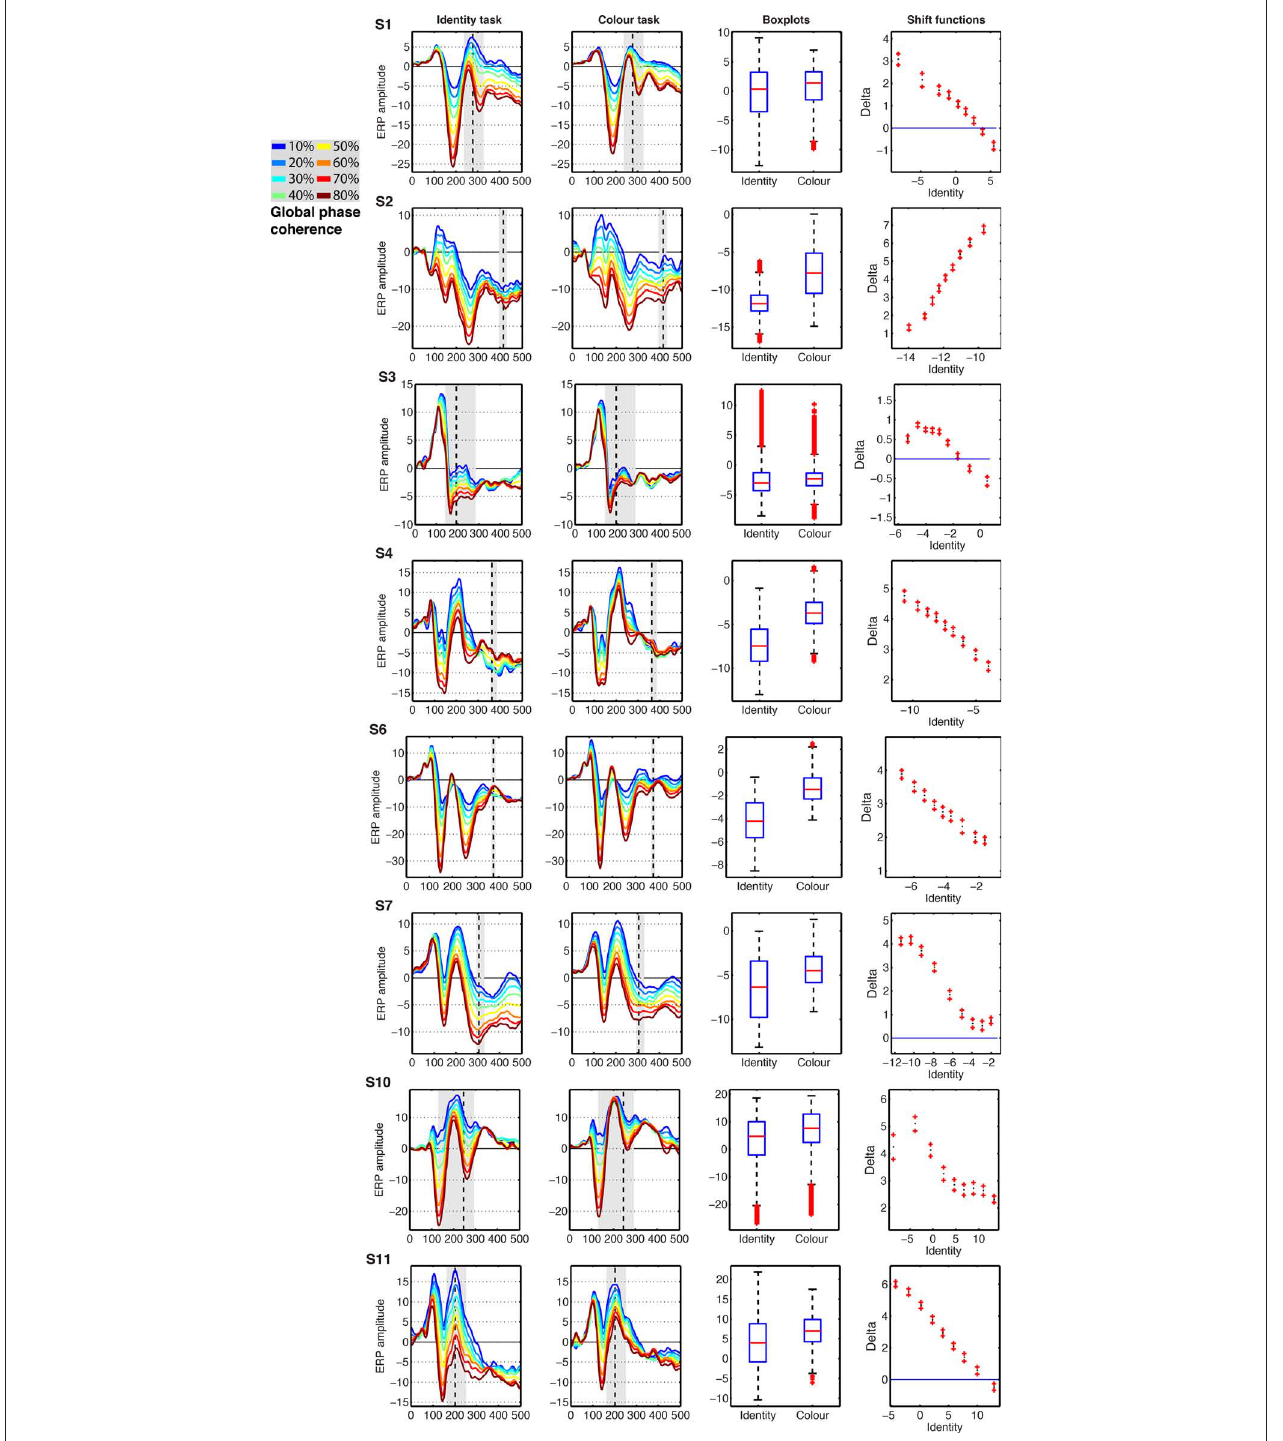
FiGuRE 12 | Event-related potentials results from the eight subjects showing significant task effects. The subject number is indicated by S# in bold font. The first two columns show the modeled ERPs in the identity and the color tasks. The vertical dashed line marks the latency of the largest task difference. The vertical gray shaded area marks all the continuous time frames at which a significant effect was observed, and which contained the time frame of maximum effect. The third column